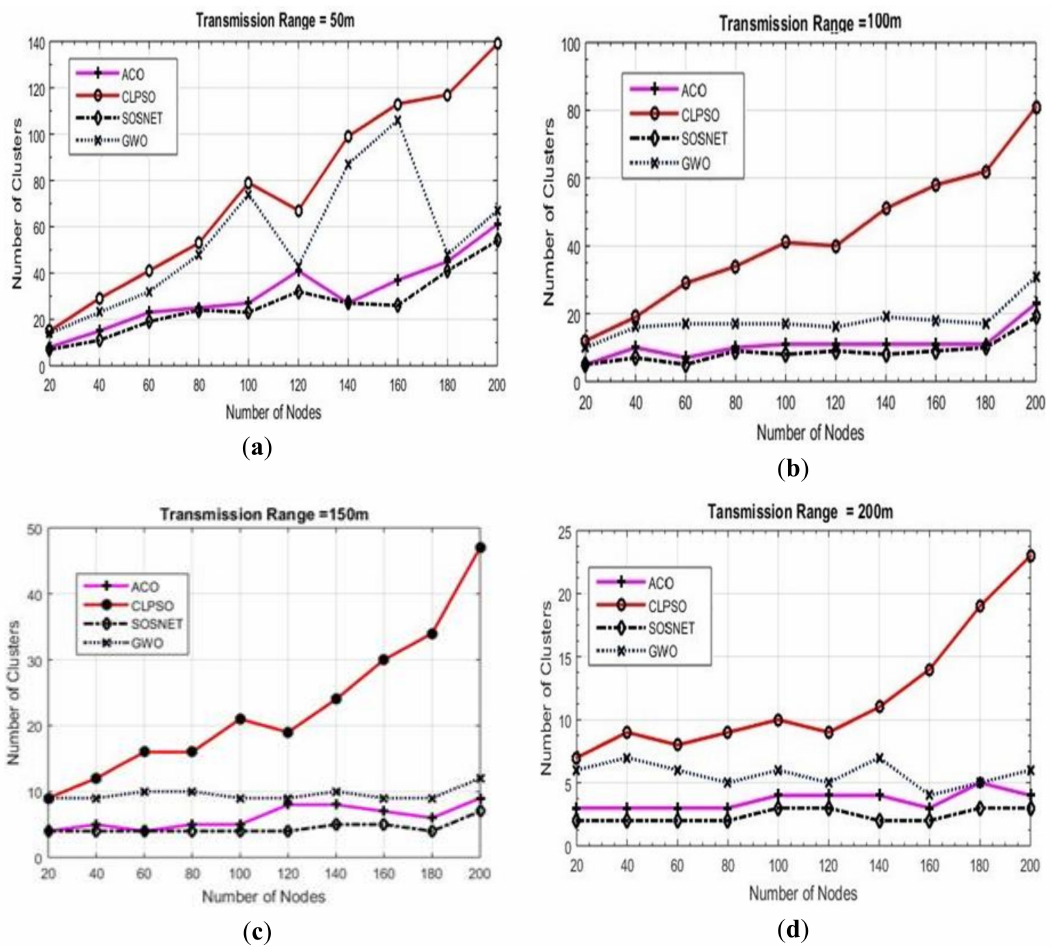
Figure 4. Grid size 500 m × 500 m, transmission ranges 50 to